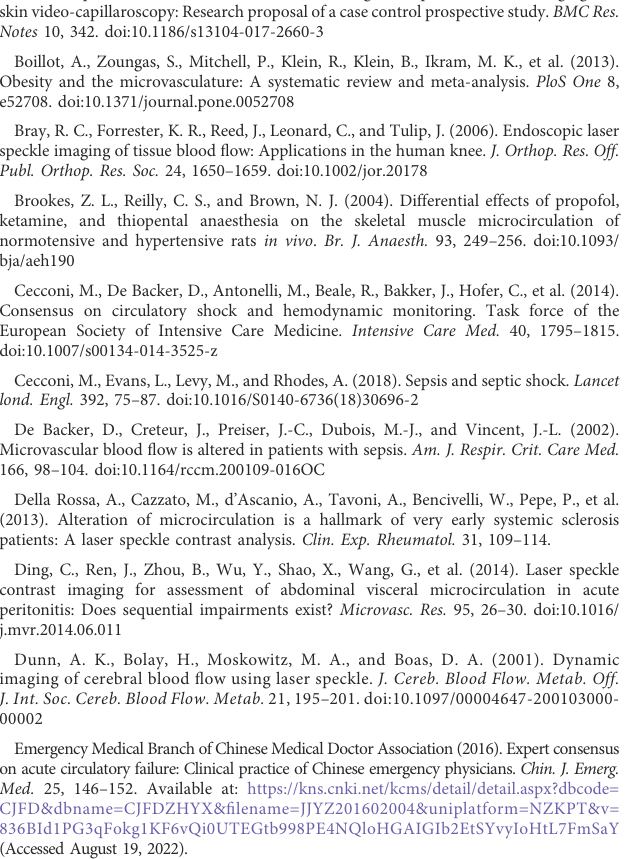
SUPPLEMENTARY TABLE S1 The p -value of baseline